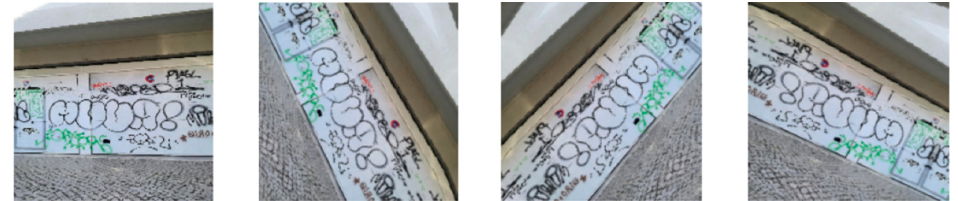
Figure 11. Example of the output of the data augmentation layers when running them repeatedly to the same image. The first image is the original one.